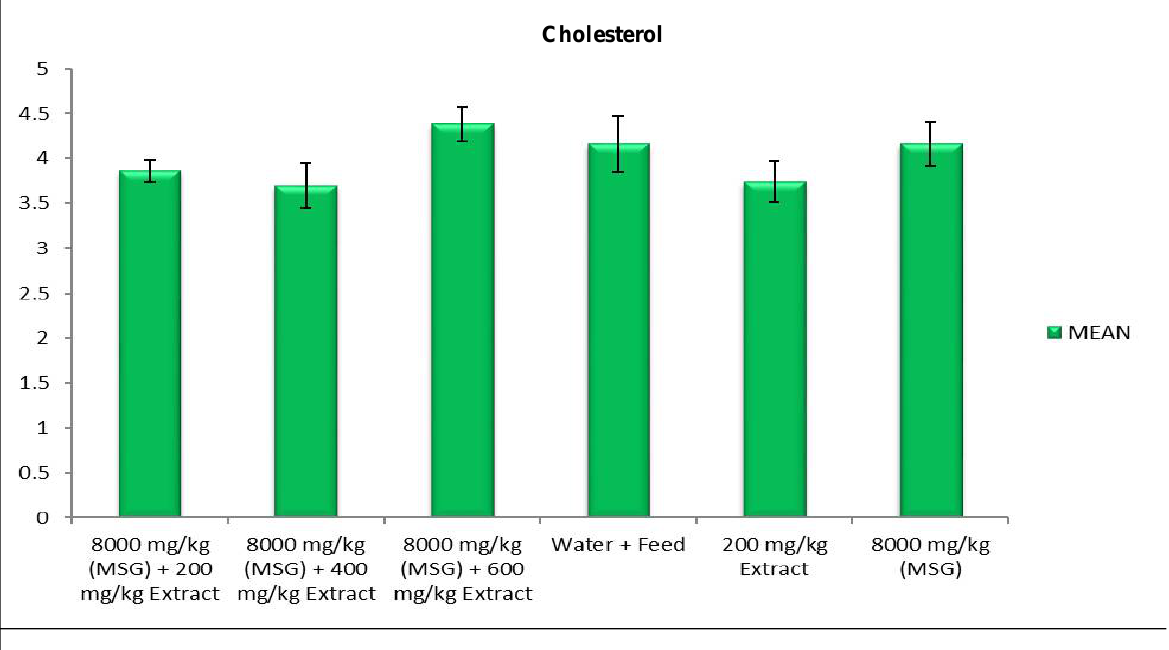
Figure 6: Effect of methanol extract of N. laevis on cholesterol (mg/dl) level of the